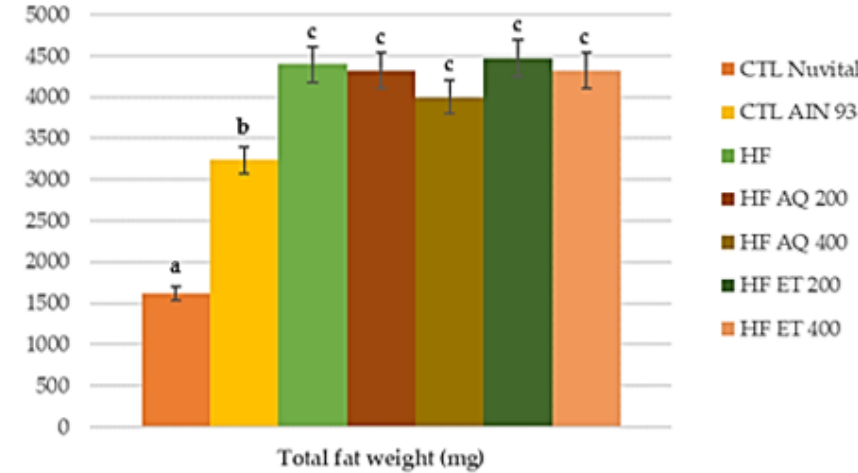
Figure 4. Total fat weight (mg) of animals fed a balanced or high-fat diet and supplemented with saline, aqueous extract or ethanol extract of G. gardneriana leaves per day for 8 consecutive weeks. Values expressed as mean ± standard deviation. Different letters indicate a significant difference between groups and groups with the same letter are not significantly different. p < 0.001; n = 6 – 11; ANOVA followed by Tukey post-test.